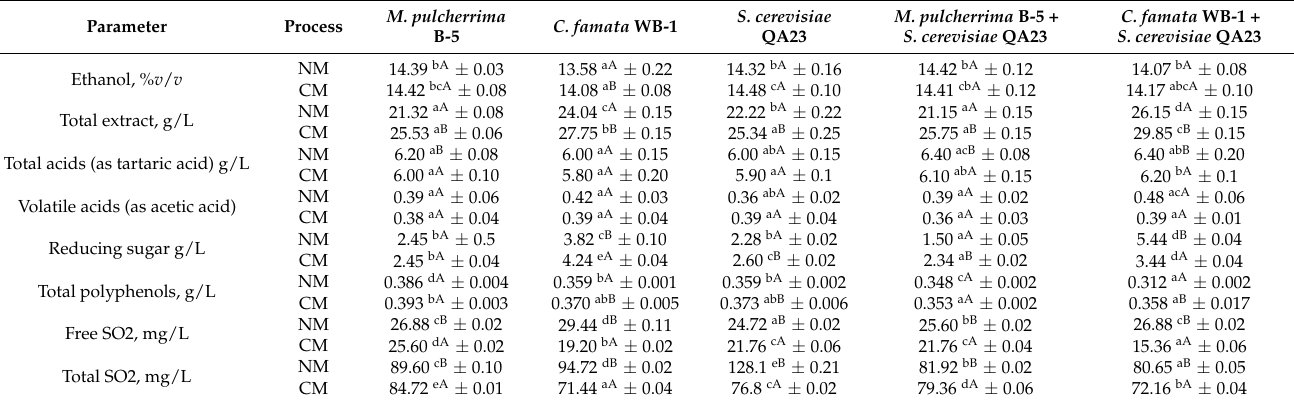
Table 1. Physicochemical analysis of wines produced with and without